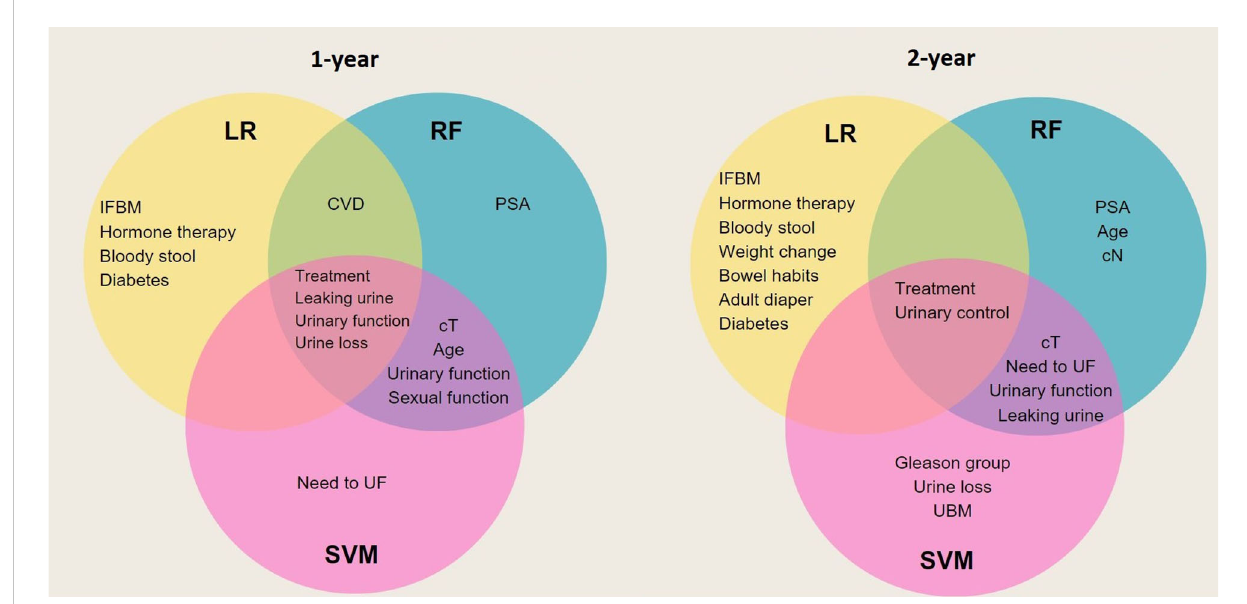
FIGURE 5 Venn diagram that illustrates overlap of predictors between generated models. Each circle represents the predictors of a speci fi c model. Those predictors that are common between all three models are placed in the center overlap area. IFBM, Increased frequency of bowel movement; PSA, prostate-speci fi c antigen; sCT, Tumor T stage; sCN, Tumor N stage; CVD, cardiovascular disease; UBM, urgency of have bowel movement; UF, urinate